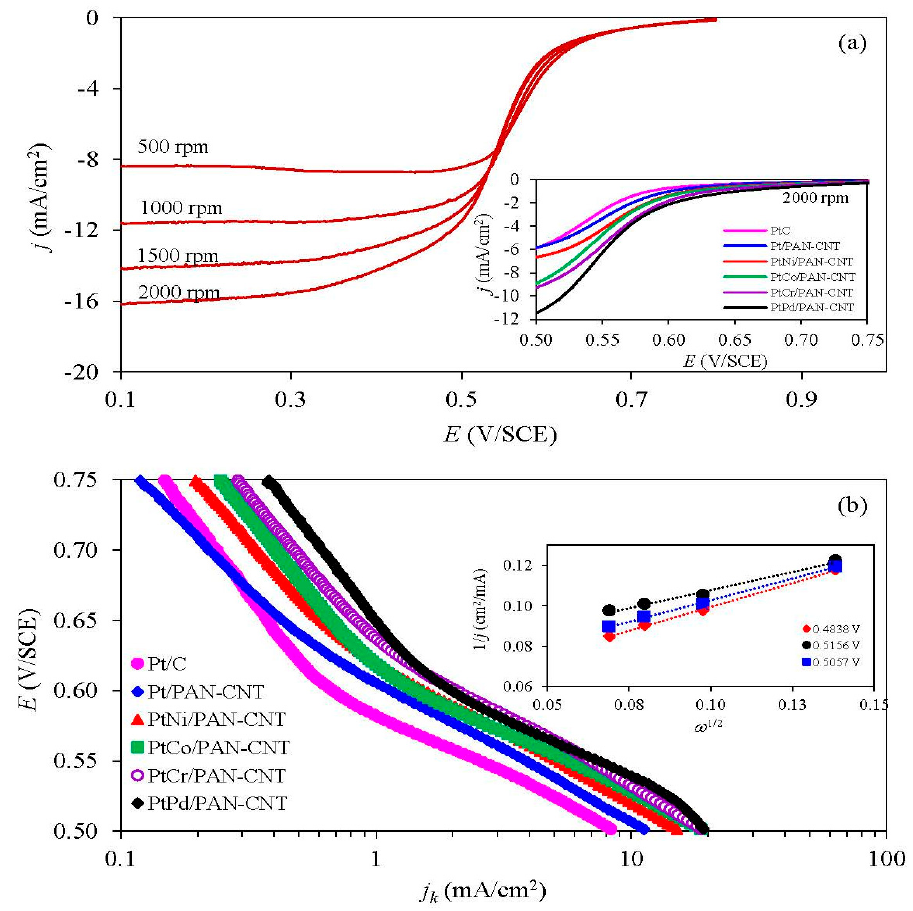
Figure 7. Representative of: ( a ) LSV with steady-state polarization curves for ORR at 2000 rpm (inset figure); and ( b ) kinetic current density with example of Levich plot (inset figure) of the different catalysts.